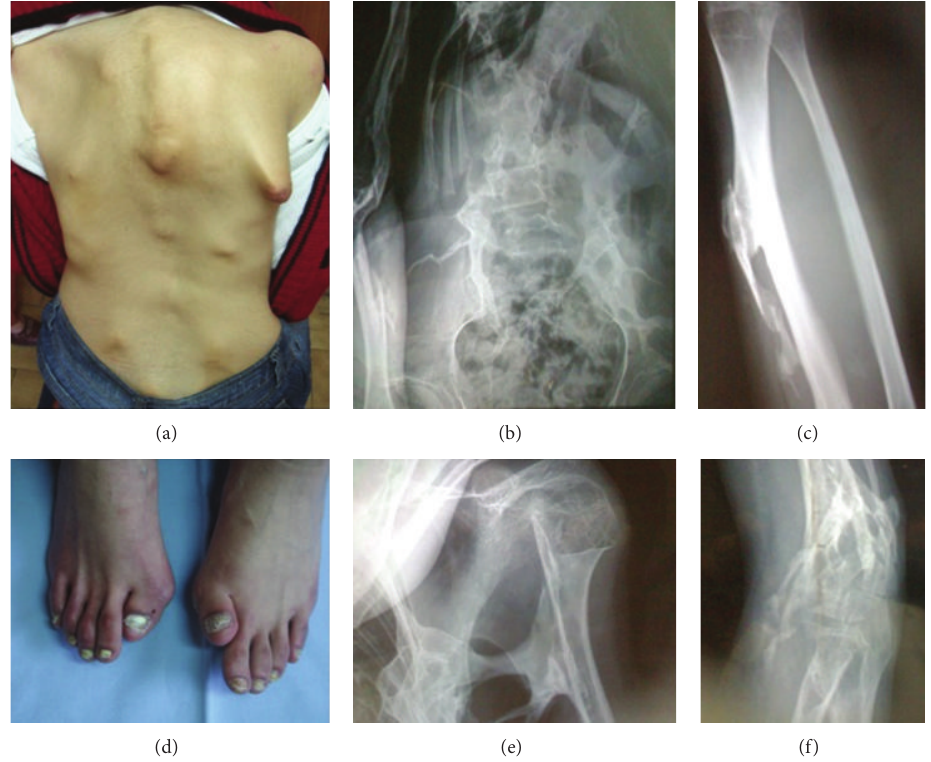
Figure 1: Clinical photograph. (a) Heterotopic ossification of the right scapular area, which functionally limited patient movement. Note the presence of pseudotumours of soft tissue at different locations in the back. (b) Column radiography showing abnormal calcification and “pseudoexostosis” indicating ligament ossification at the site of attachment. (c) Right forearm with cubit exostoses dependent on ligaments and aponeuroses. (d) Congenital malformations of the great toes. (e) Radiography of the right scapula and (f) right elbow shows abnormal calcification dependent on ligament